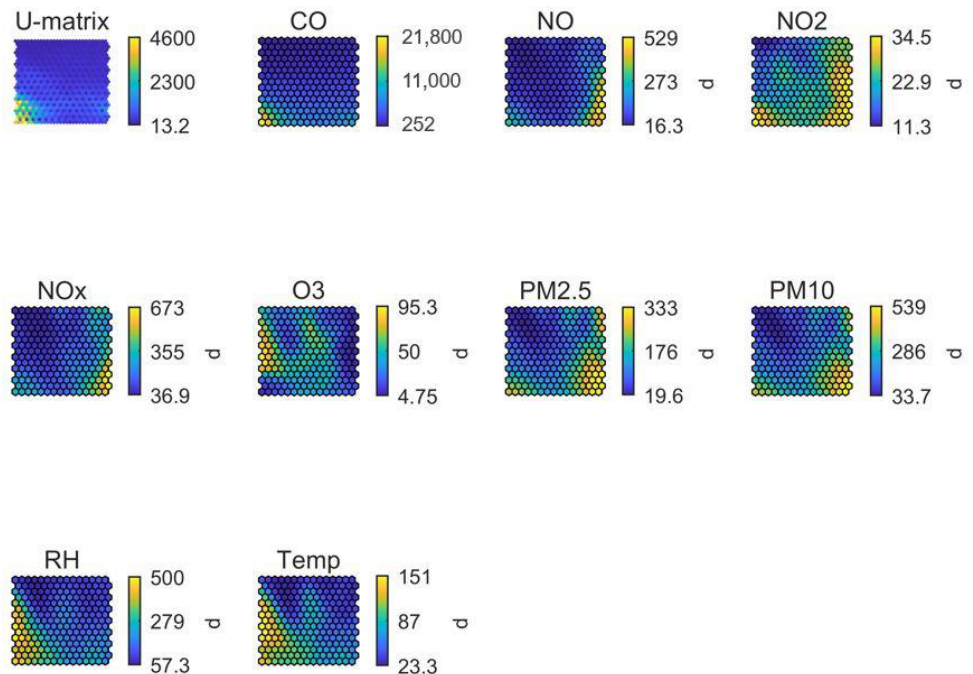
Figure 6. SOM of available data for stadium #2, in Africa. The colour scale is automatically adjusted among graphs and does not reflect the full range of values per parameter.